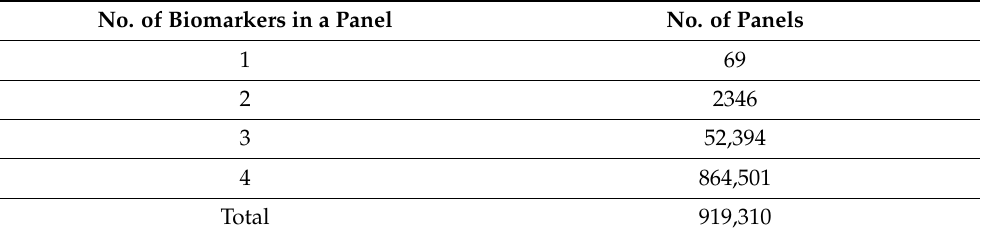
Table 9. Number and distribution of panels with one, two, three, and four